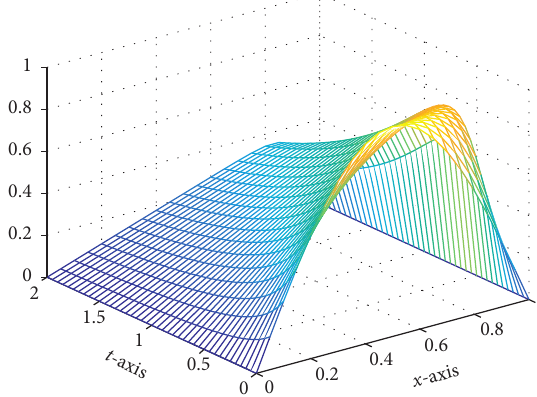
Figure 3: Graph of the numerical solution of u h � Δ t �